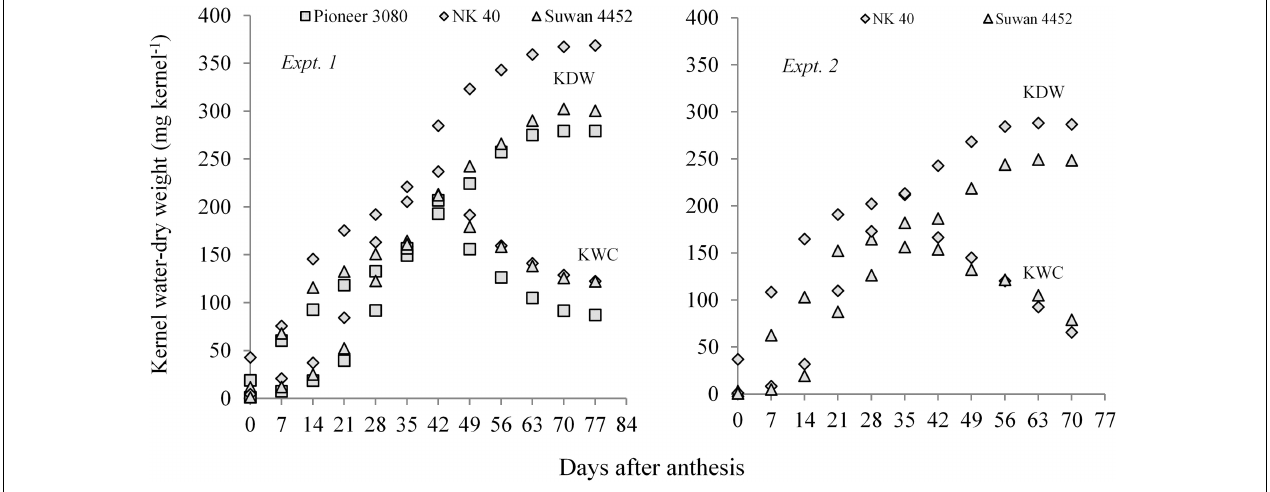
FIGURE 5 | Kernel water content (KWC) and kernel dry weight (KDW) of field maize hybrids after anthesis to physiological maturity at 7 days interval irrespective of water regimes in Expt. 1 and Expt. 2,